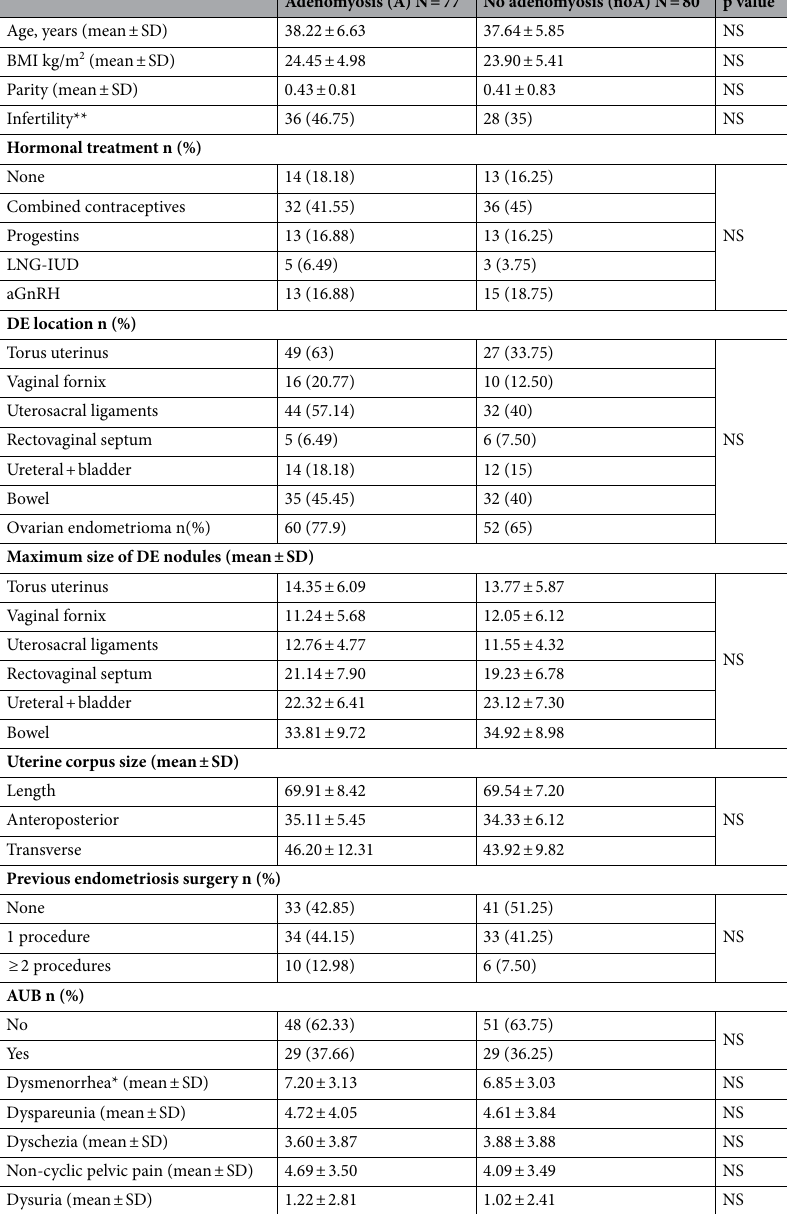
Table 1. Clinical characteristics and endometriosis-related symptoms. Data are given as n or %. Symptoms are expressed with Numeric Rating Scale (NRS). LNG-IUD Levonorgestrel Intra Uterine Device, aGnRH analog- regular monthly periods: 14 patients in the A group (18.18%) and 13 in the noA Group (16.25%). **Infertility: was defined as the failure to achieve pregnancy after 12 months without investigations or